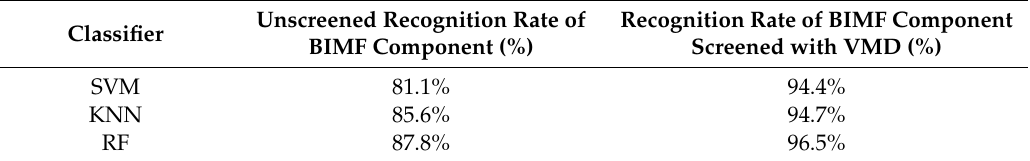
Table 1. Average recognition accuracy after screening the VMD components based on mutual